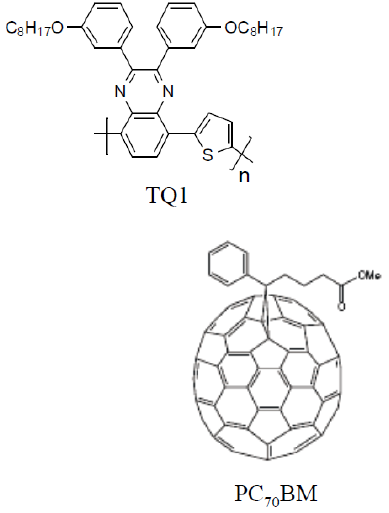
Figure 1. Chemical structure of a quinoxaline-based donor polymer (TQ1) and a [6,6]-phenyl-C 71 - butyric acid methyl ester (PC 70